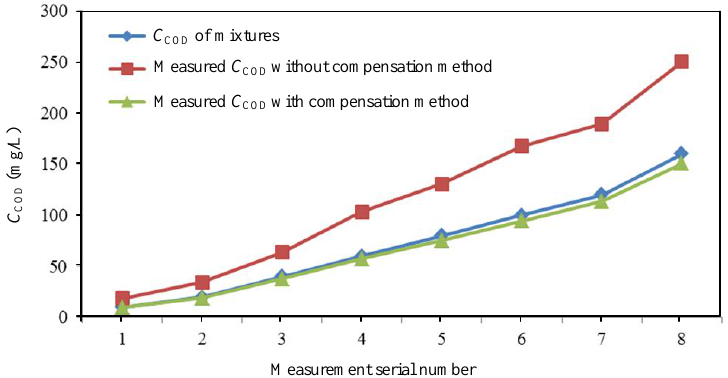
Figure 5. Mixed solution C COD measured results.